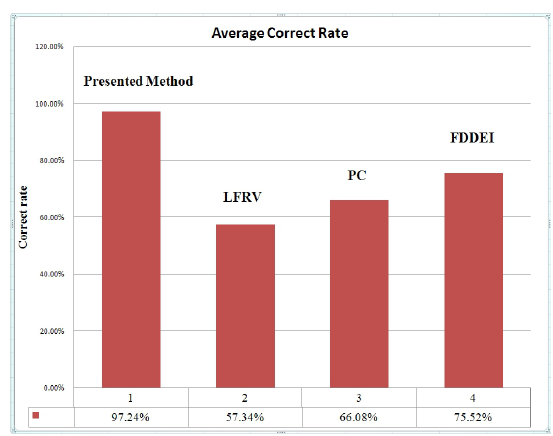
Figure 5. Correct Rate obtained from four different methods